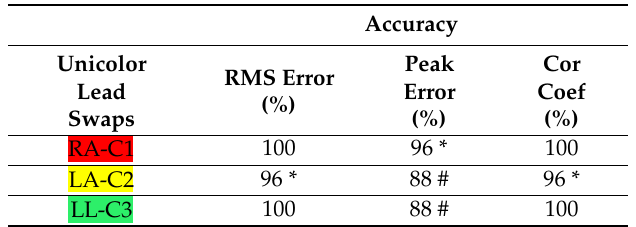
Table 6. Accuracy for the detection of the exact lead swaps, applying the ‘MSMinv’ transformation on 3 swapped recordings (RA-C1), (LA-C2), (LL-C3) from 25 patients in our database. Color of electrodes follows IEC standard